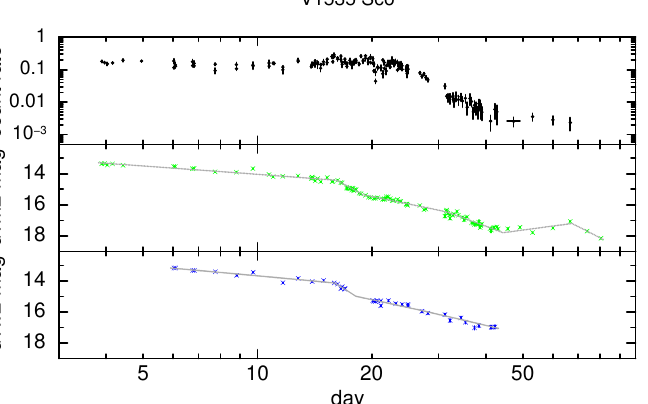
Figure 10. The XRT and UVOT light-curves of V1535 Sco, with the best-fit broken power-law decline shown as the grey solid line. Data were only collected with the uvw 1 filter intermittently for the first 19 days, so have not been included. The X-ray data (top) are in count s − 1 over 0.3–10 keV.